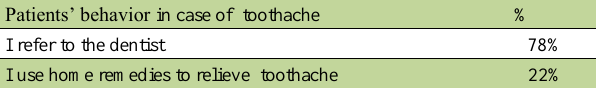
Table 1. The patients’ own experience regarding root canal treatment.